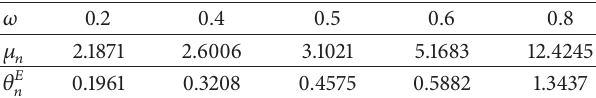
Table 2: Einstein rings and magnifications for 𝑛 = 2 .